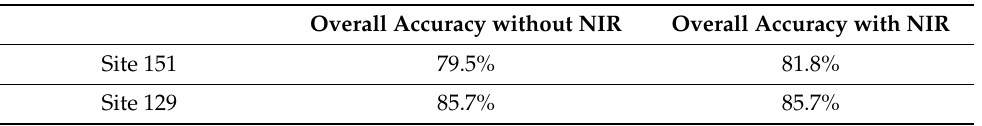
Table 7. Summary of overall accuracies with and without using the NIR imagery for the two sites where NIR imagery was